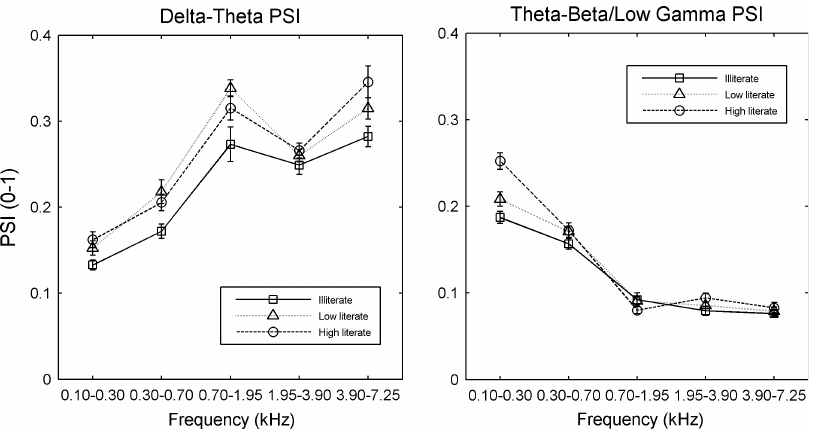
Fig 3. Phase synchronisation index (PSI) values by frequency band for delta-theta amplitude modulation bands (left panel) and theta-beta/low gamma amplitude modulation bands (right panel) for conversational speech recorded from illiterate, low literate and high literate adults. The x-axis indicates the spectral bands from which the amplitude modulations originate. The y-axis shows the PSI value. Error bars are in standard error of the mean.